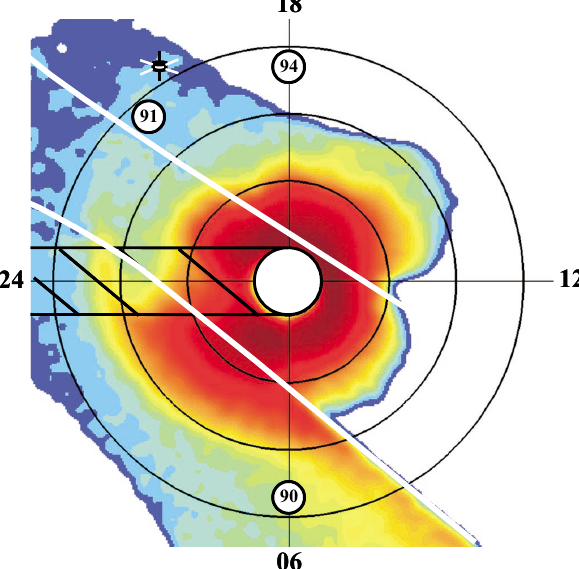
Fig. 7. Projection of a full-frame EUV image onto the equatorial plane at 08:31 UT on 7 May 2002. The white disk in the centre of the image corresponds to the size and position of the Earth, with its shadow extending away from the Sun. The three large circles correspond to R equat =3, 5 and 7 R E . The two white lines corre- spond to the limits between the three EUV cameras. The position of the CLUSTER satellites is indicated on the EUV image, as well as the positions of three geosynchronous satellites: LANL 1990- 095, LANL 1991-080 and LANL